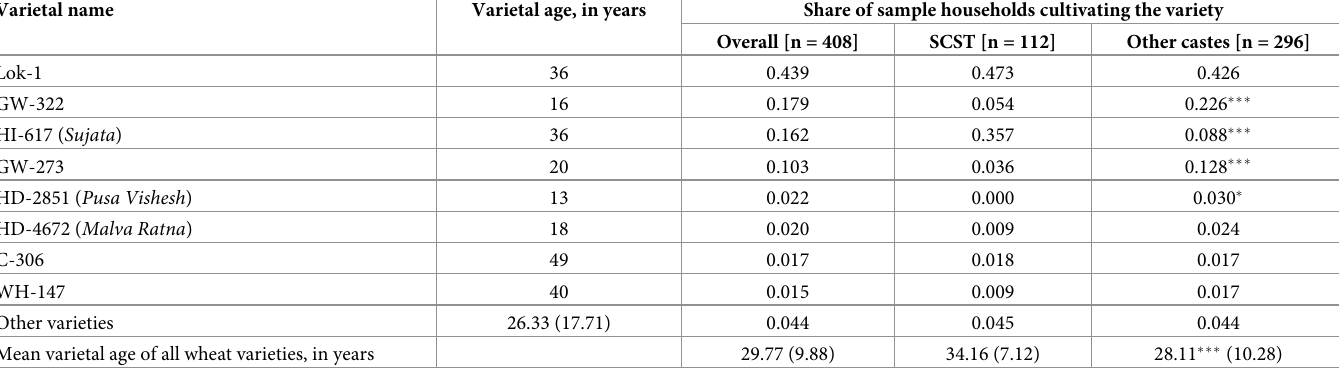
Table 2. Wheat varieties grown in the study